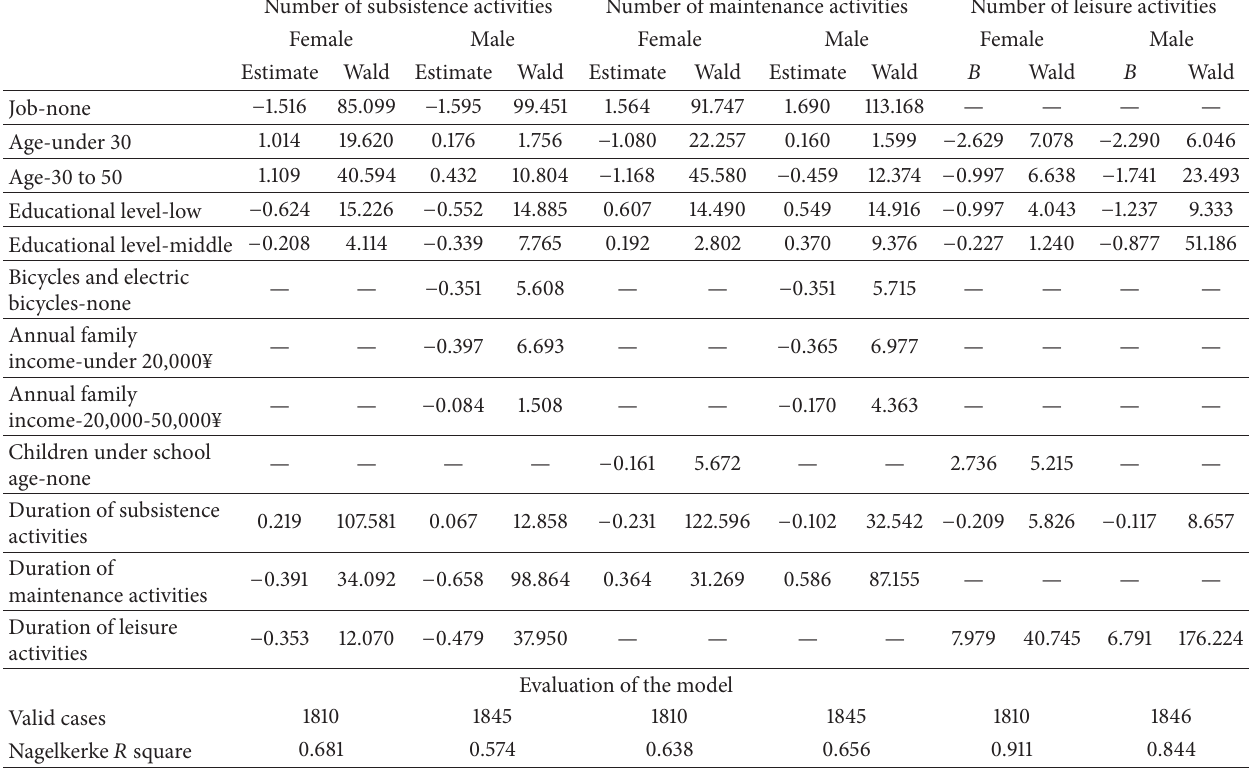
Table 5: Logistic regressions for number of subsistence, maintenance, and leisure activities